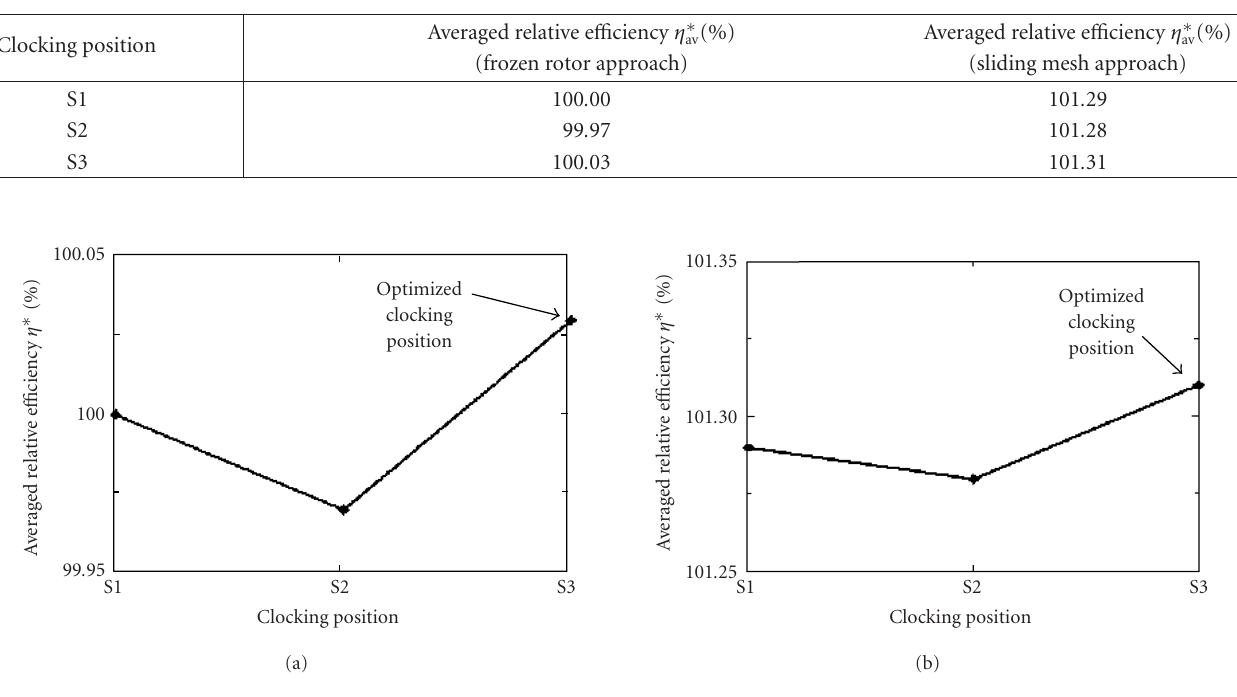
Table 3: Averaged relative e ffi ciency distributions.